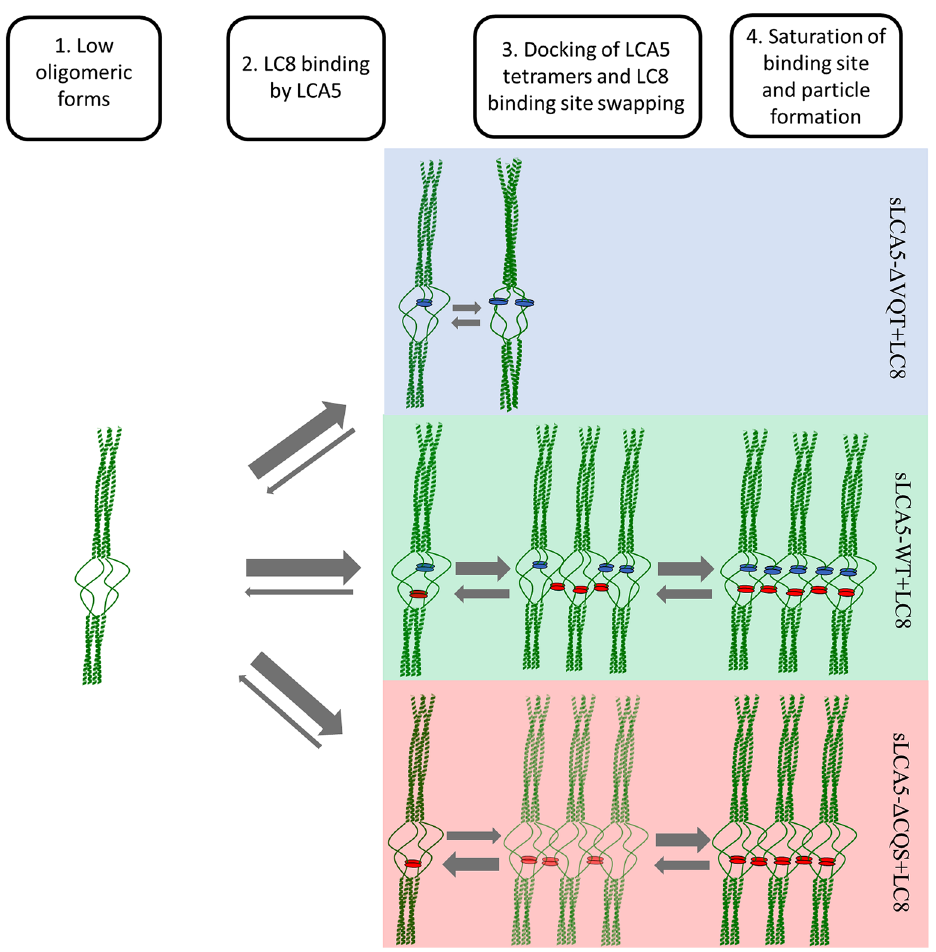
Figure 7. LC8 dependent oligomerization model of LCA5. An initial low oligomeric state is possibly the native form of LCA5 without the binding of LC8. The addition of LC8 to the single mutants and to the wild type initiated an oligomerization process dependent on the affinity of the presented linear motifs and the number of binding sites. The sLCA5-ΔCQS-ΔVQT form, lacking any LC8 binding sites, mostly remains in the initial low oligomeric state. In case of sLCA5-ΔVQT, the low affinity CQS motif is able to bind LC8, but the equilibrium of complex formation is likely shifted towards the formation of saturated tetrameric complexes. The higher affinity motif containing sLCA5-ΔCQS mutant is able to form higher order oligomers by swapping the intra-tetrameric crosslinks to inter-tetrameric ones, but the one presented motif is not enough to stabilize the intermediate forms in a detectable amount (faded intermediate form) . The wild type sLCA5-WT could form higher order oligomers in a more effective way in accordance with its increased crosslinking potential compared to the single mutant constructs and forms stable complexes in the range of tetramers to higher order oligomers. The blue spheres represent the N-terminal low affinity motif binding LC8 molecules, the red spheres the higher affinity ones. The thickness of the arrows are proportional to the shifting of the equilibrium of complex